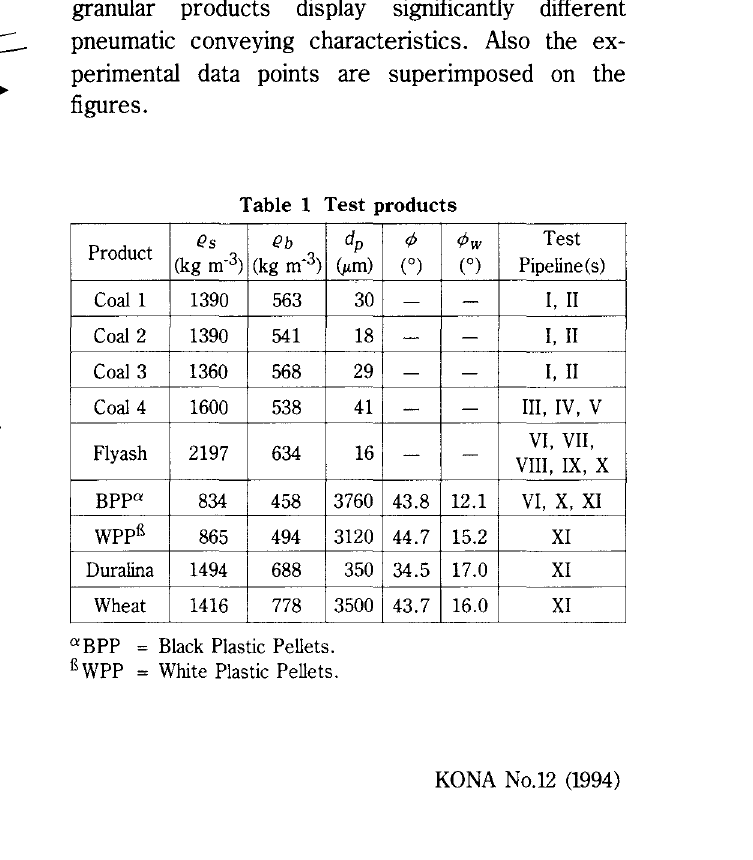
Fig. 1 General form of pneumatic conveying characteristics for fine products